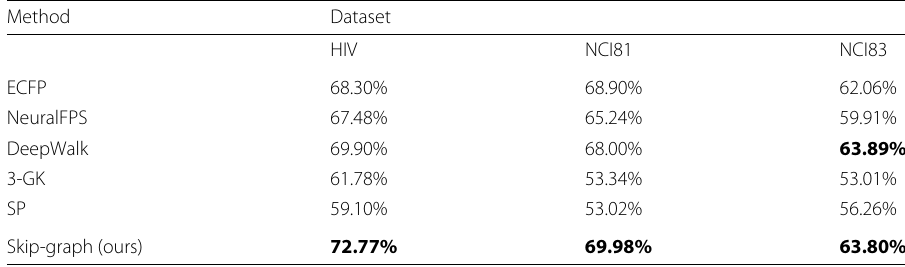
Table 2 Summary of experimental